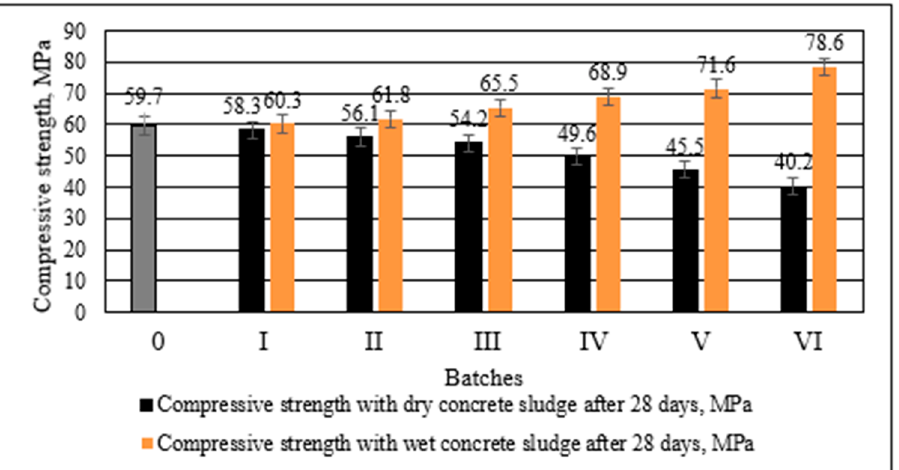
Figure 10. Compressive strength of concrete with different amounts of cement replaced with wet and dry concrete sludge after 28 days.